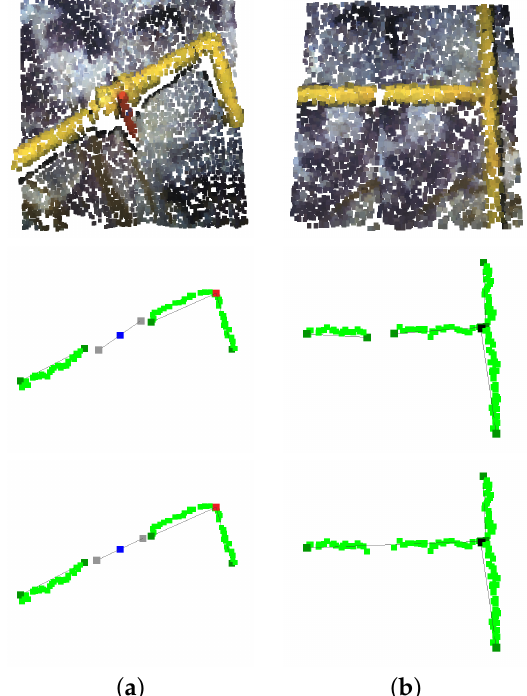
Figure 9. Information refinement: ( a ) Valve vector reorientation; ( b ) Pipe vector unification. Top: Original point cloud. Middle: information before refinement. Bottom: information after